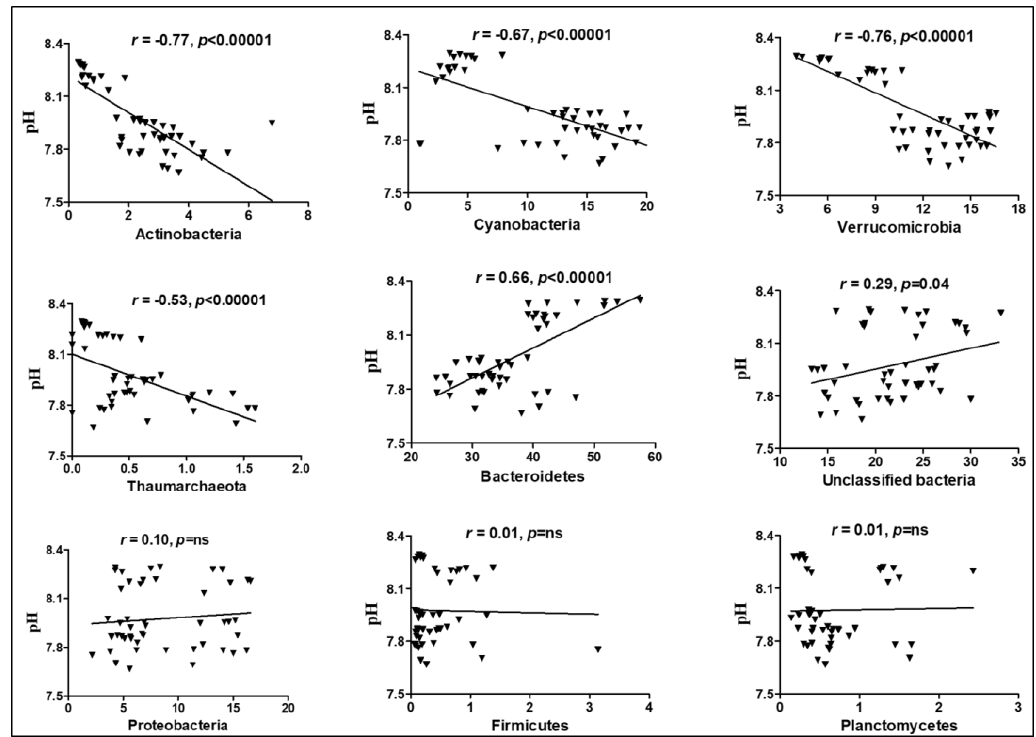
Figure 9. Linear regression analysis between microbial diversity at phylum level and environmental variable pH. The relative abundance and pH values are provided in x and y axes, respectively. Correlation coefficient and p -values are provided in the figure